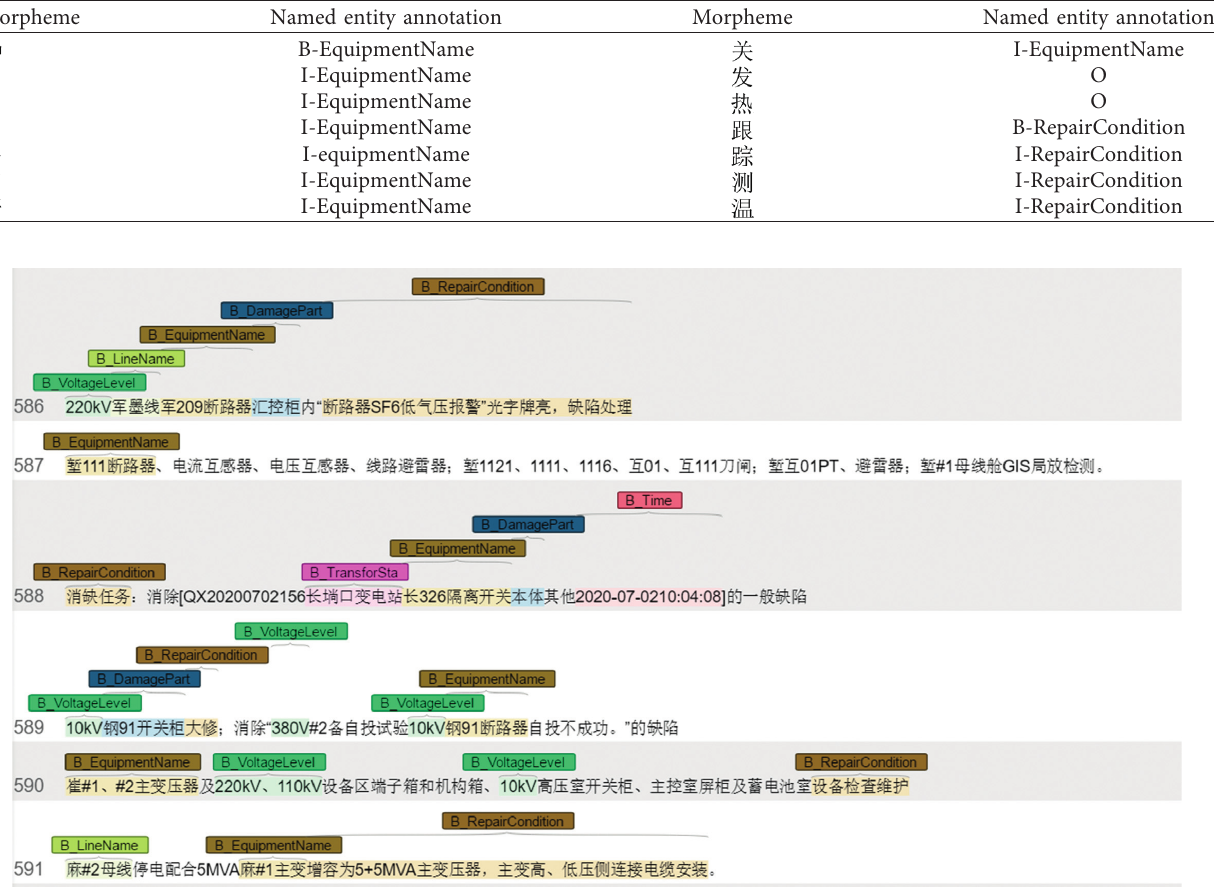
Table 1: Example of text labeling of maintenance records ( means clock 226 isolation switch fever tracking temperature measurement).